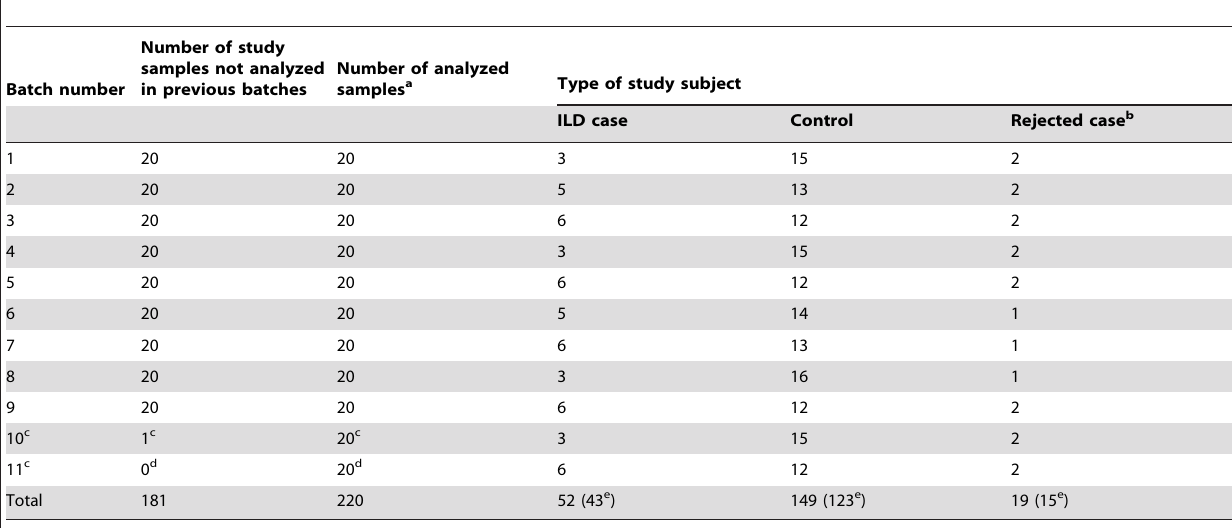
Table 1. Composition of the LC-MS/MS measurement batches for 181 blood plasma samples from Japanese patients with NSCLC.